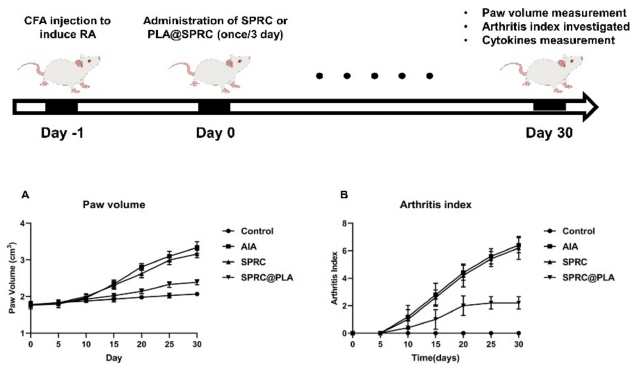
Figure 7. The ( A ) paw volume was measured by plethysmometer, and the ( B ) arthritis index were assessed using the arthritis scoring system to evaluate the severity of swollen symptoms ( n = 5, mean ± SD).